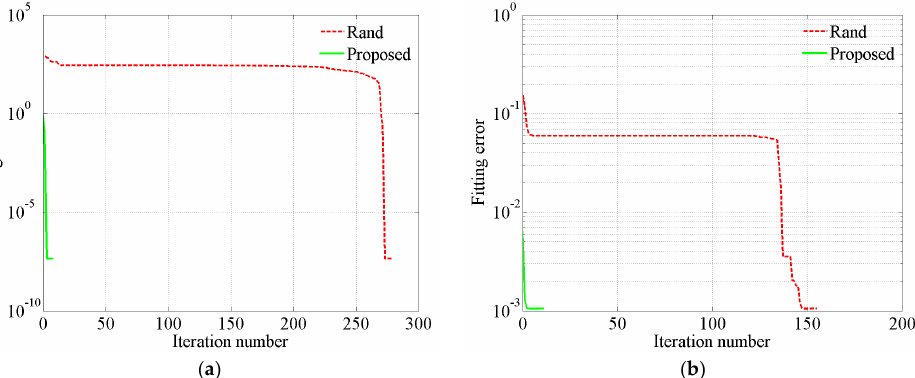
Figure 5. Change of the sum of the squared normal distances with iteration number. ( a ) Noise-free; ( b ) Noisy. Table 6. Statistical results of errors in the key parameters extracted by different algorithms, numerically generated signals.